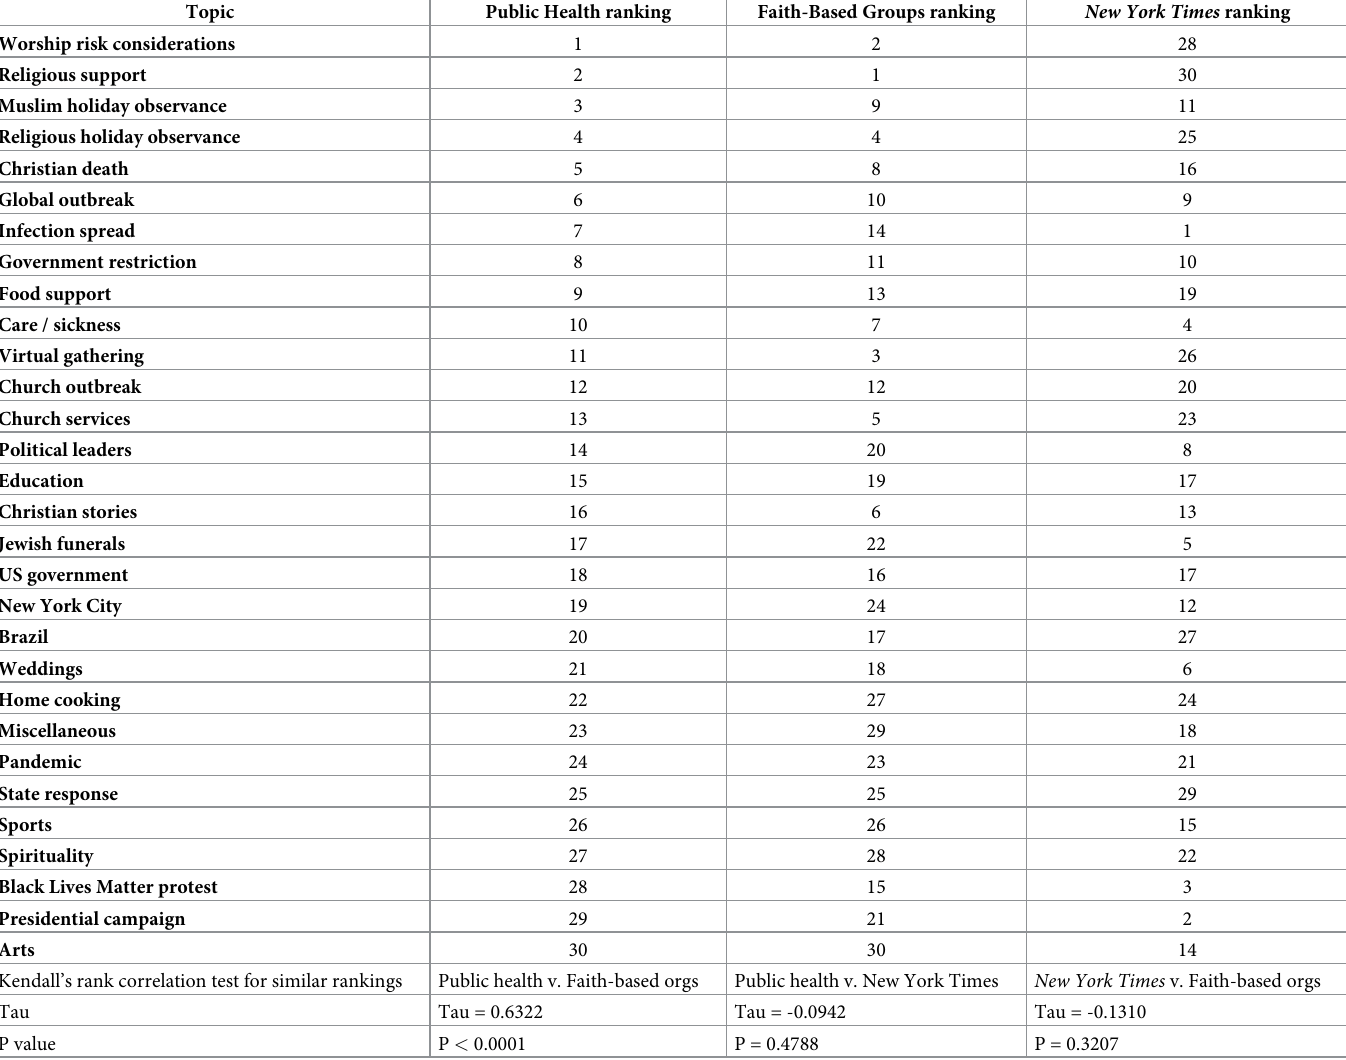
Table 2. Ranking of topic prevalence by source: Public health, faith-based groups, New York Times . Topic Public Health ranking Faith-Based Groups ranking New York Times